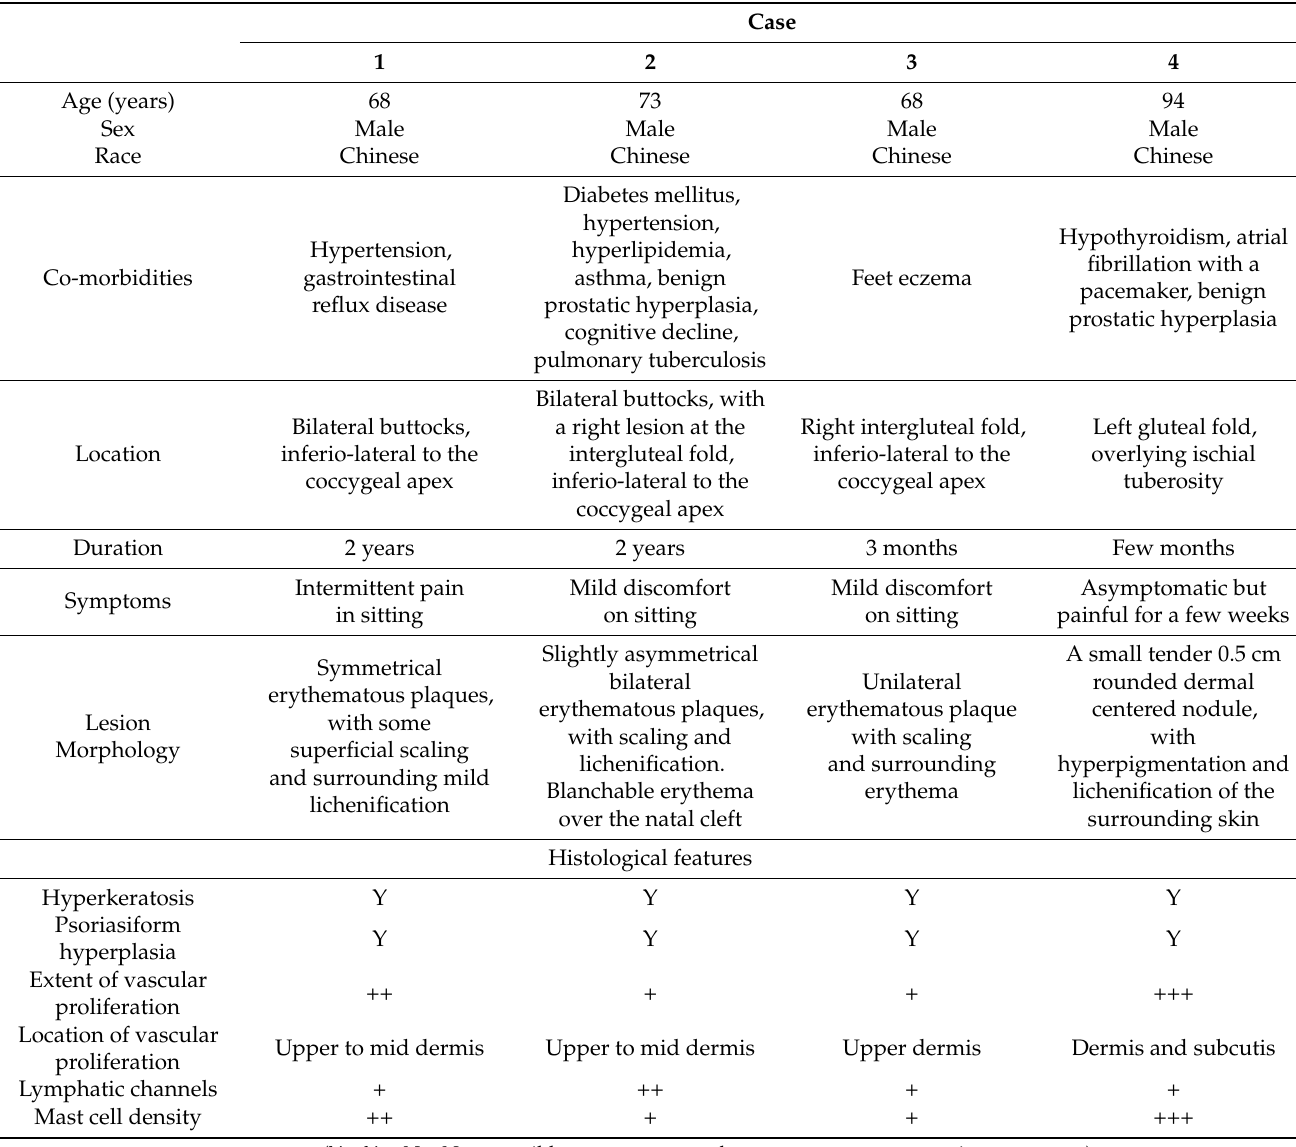
Table 1. Characteristics and features of the four patients with